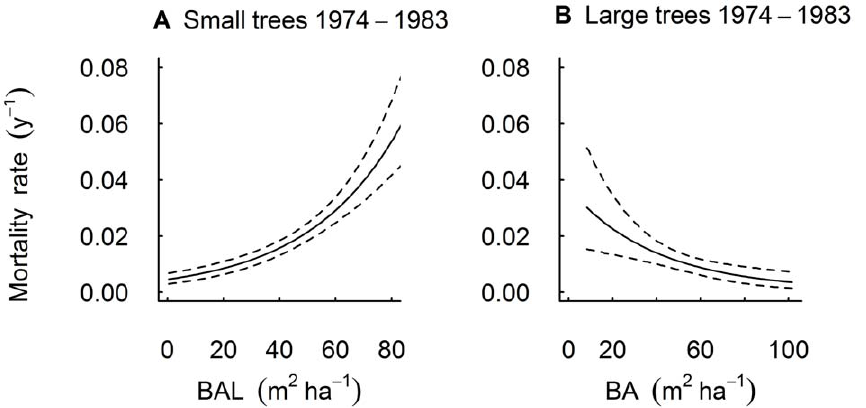
Figure 5. Predicted mortality against neighbourhood crowding variables. Predicted effect of ( A ) basal area of larger neighbours (BAL, m 2 ha 2 1 ) on mortality for small (D , 20 cm) trees, and ( B ) basal area (BA, m 2 ha 2 1 ) on mortality for large (D $ 20 cm) trees over the 1974–1983 census period. The solid line shows predicted relationships as determined from simulations drawing on the posterior distribution of parameter estimates. Dashed lines show the 95% credible intervals of the